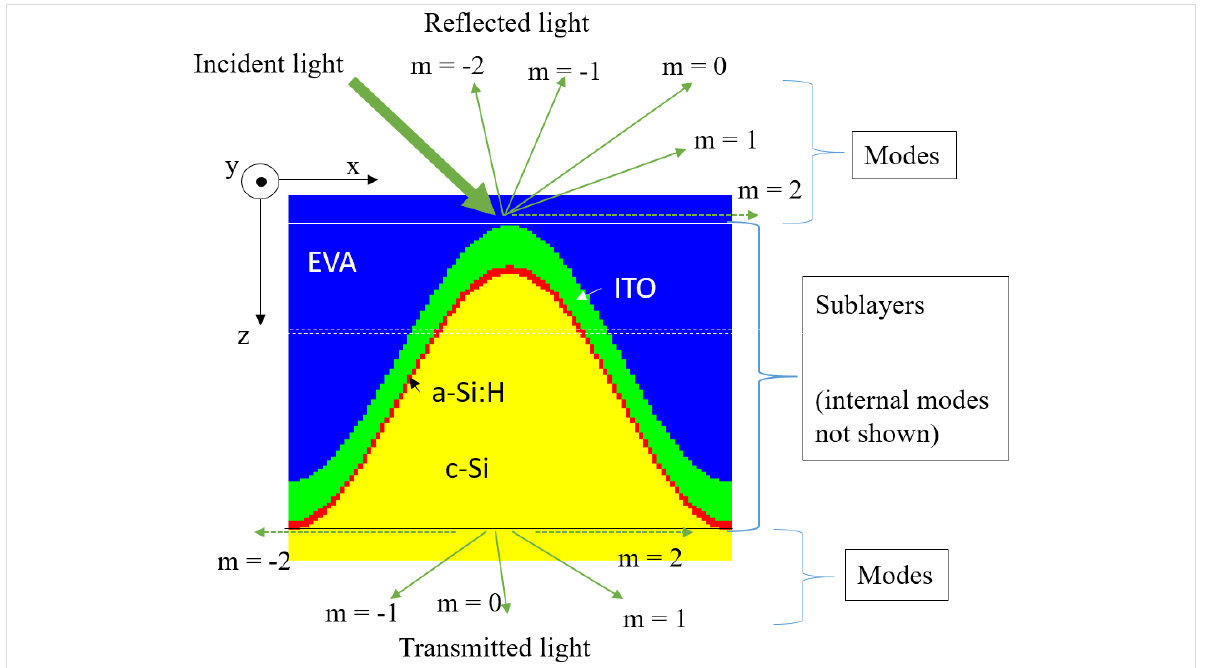
Figure 1: Vertical cross-section of a sliced three-layer structure with texture applied to the bottom layer (sine texture shown in this example). The dif- ferent of the layers are indicated by different colors. The structure was in this case sliced to 100 sublayers; a selected one is emphasized by thin dashed horizontal lines. The case for the maximum mode number, M = 2, is shown, which corresponds to a total number of modes equal to 25 in 3D simulations (in this 2D cross-section only five modes are depicted (including evanescent modes) for reflected and transmitted light). The internal modes of each sublayer are not